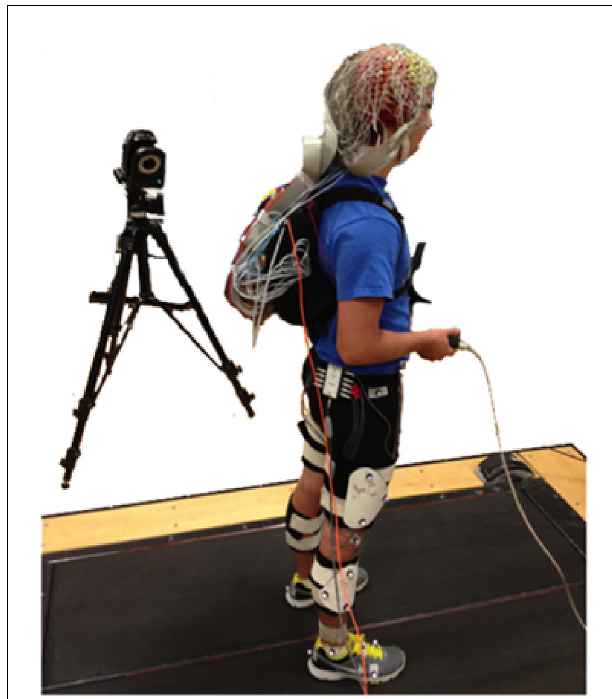
FIGURE 1 | 20 subjects stood (0.0 m/s) and walked (0.4, 0.8, 1.2, and 1.6 m/s) on a treadmill while continuously performing the Brooks spatial working memory task. We recorded EEG, kinematics, ground reaction forces, and response data from the Brooks task.